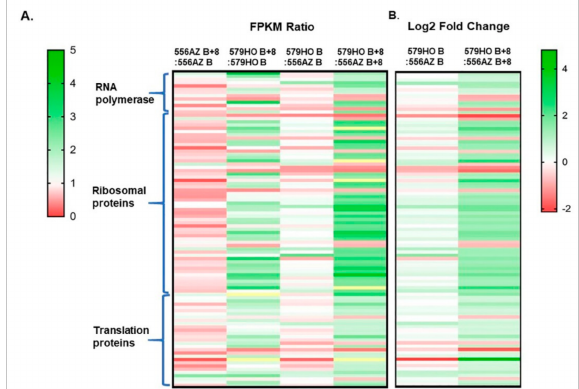
Figure 5. Heatmaps of gene expression analysis of the identified RNA polymerases, ribosomal proteins, and translation protein genes in 556AZ and 579HO lines at breaker (B) and breaker + 8 (B + 8) stages. Panel ( A ) shows FPKM expression ratios at B and B + 8 stages for 556AZ B + 8:556AZ B and 579HO B + 8:579HO B and between two lines (579HO B:556AZ B and 579HO B + 8:556AZ B + 8). Panel ( B ) highlights “di ff erential” expression as log2 fold change in 579HO line as compared with 556AZ at two ripening stages. Heatmaps were performed using GraphPad Prism version 7.0 for Windows, GraphPad Software, La Jolla, CA, USA, www.graphpad.com.